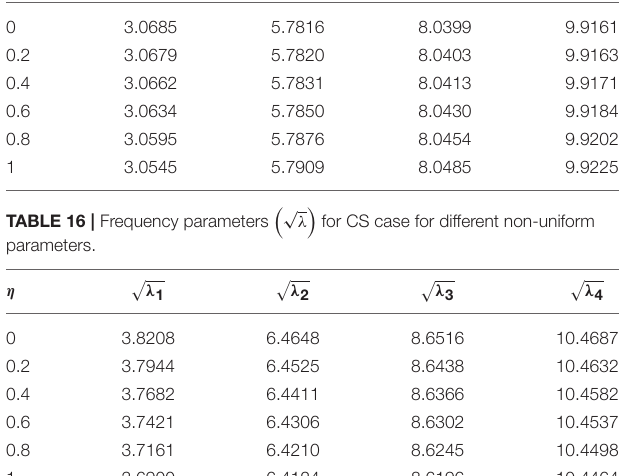
√ λ for SS case for different non-uniform (cid:16) (cid:17)